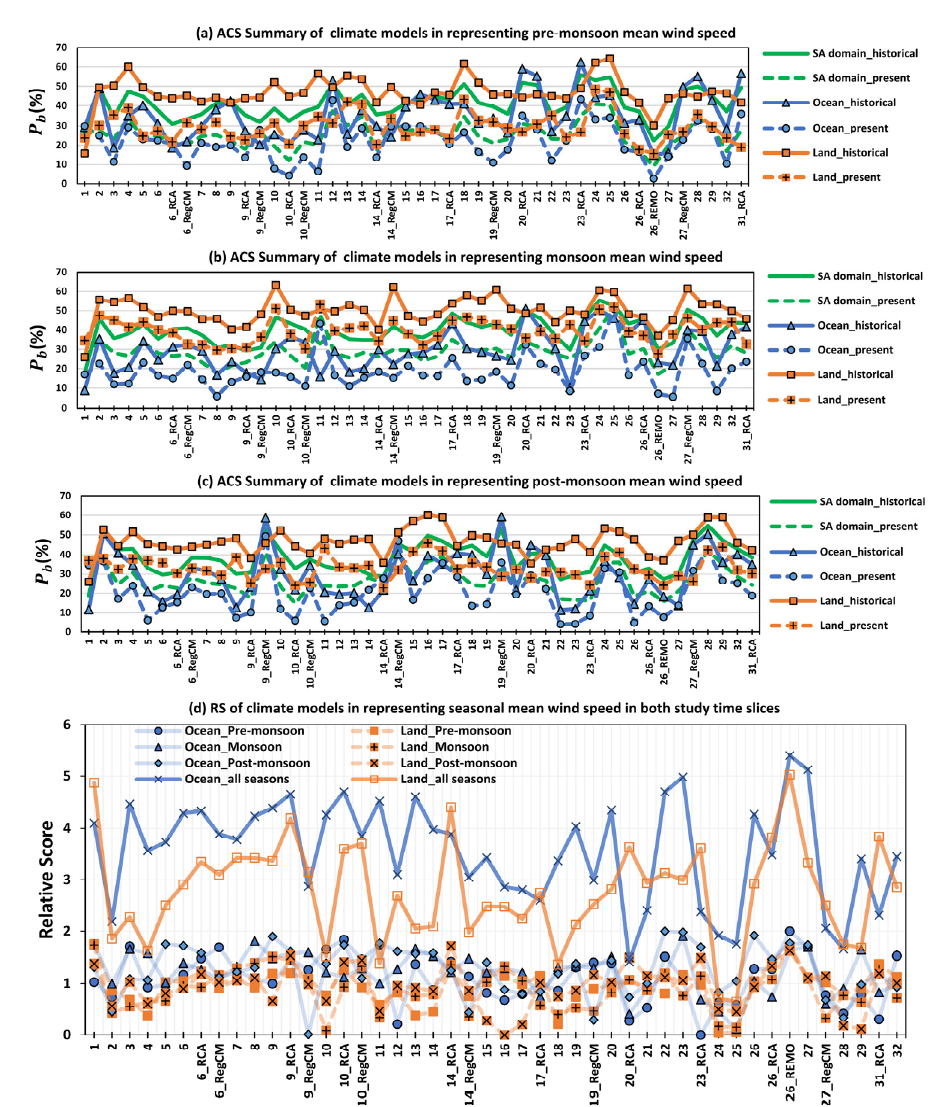
Figure 5. ( a ) Represents the Assessment Criterion Statistic (ACS) summary of climate models in simulating pre-monsoon (February–May) mean wind speed over South Asian (SA) domain for historical period (1979–2005) (green solid line), over SA domain for present period (2006–2019) (green dashed line), over ocean for historical period (blue solid line with triangle markers), over ocean for present period (blue dashed line with circle markers), over land for the historical period (orange solid line with plus sign markers) and over land for present period (orange dash line with square markers); percentage of statistically significant bias ( P b , %) on y-axis and Model ID on x-axis. ( b ) As in ( a ), but for monsoon season (June–September). ( c ) As in ( a ), but for post-monsoon season (October–January). ( d ) Relative Score (RS) (summation of relative score over both time slices) of each climate model in simulating seasonal mean wind speed, over ocean (blue solid line) for pre-monsoon (circle markers), monsoon (triangle markers), post-monsoon (diamond markers) and for all three seasons (thick solid blue line with cross sign markers), and over land (orange dashed line) for pre-monsoon (filled square markers), monsoon (plus sign square markers), post-monsoon (cross sign square markers) and for all three seasons (thick solid orange line with square markers).